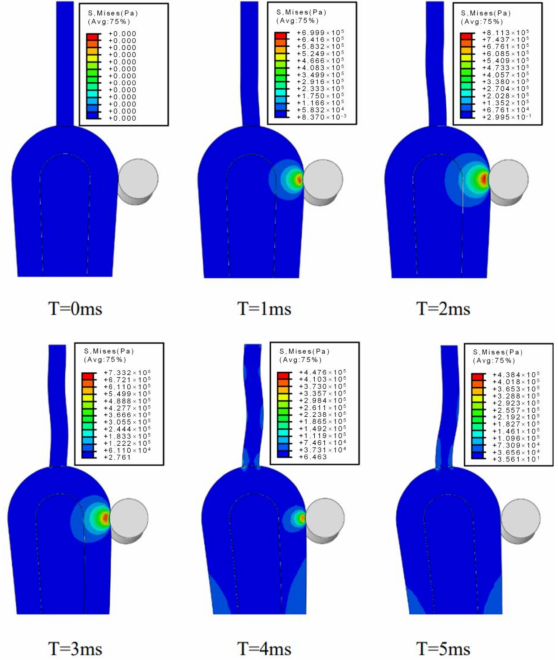
Figure 9. Simulation results of impact.